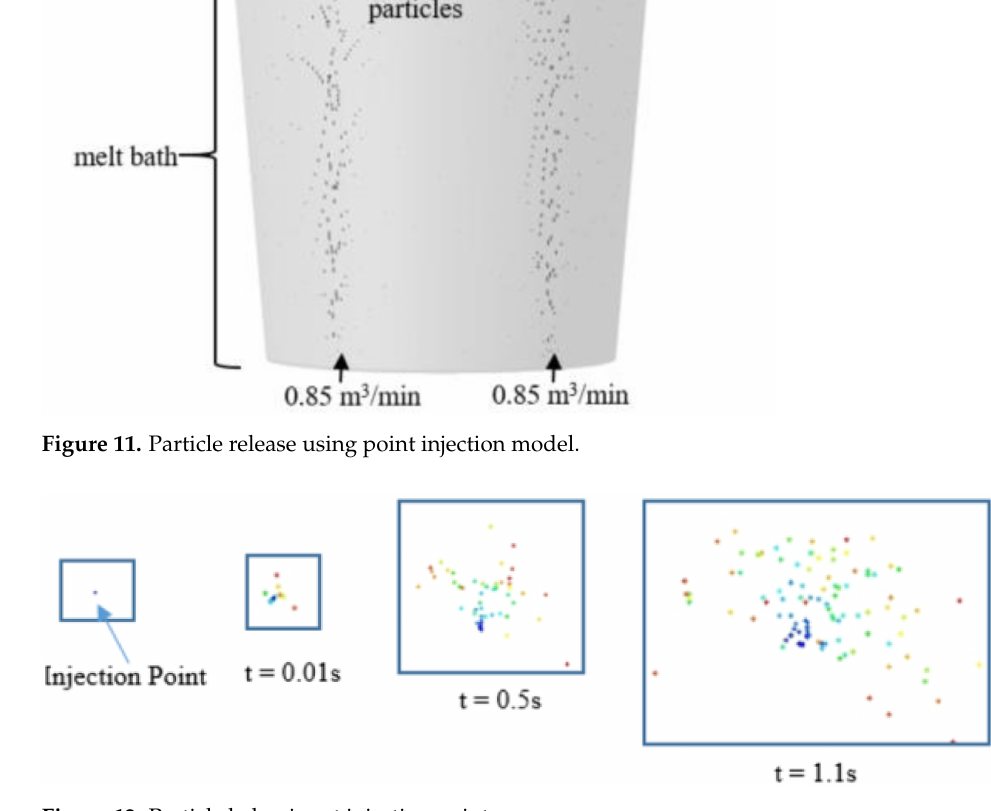
Figure 12. Particle behavior at injection